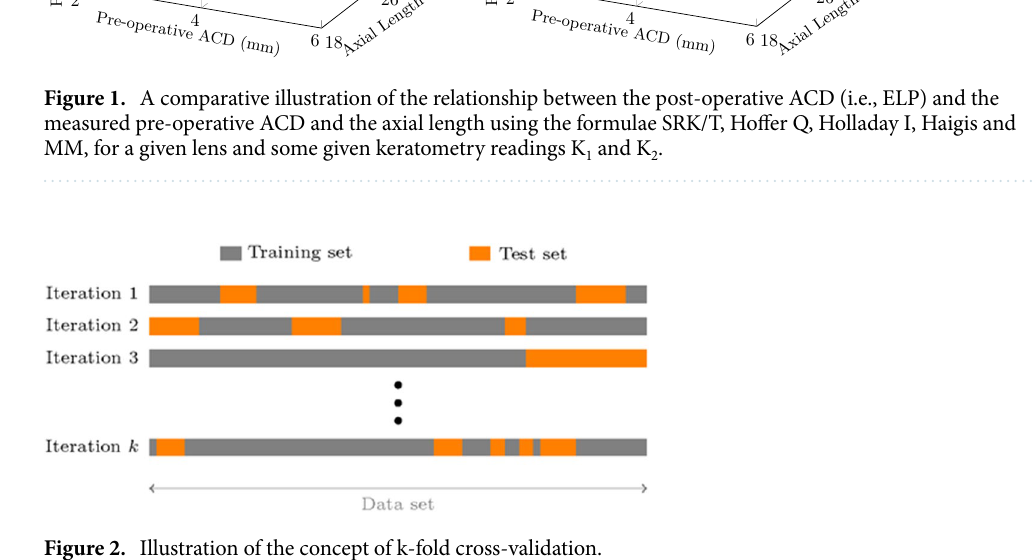
Figure 2. Illustration of the concept of k-fold